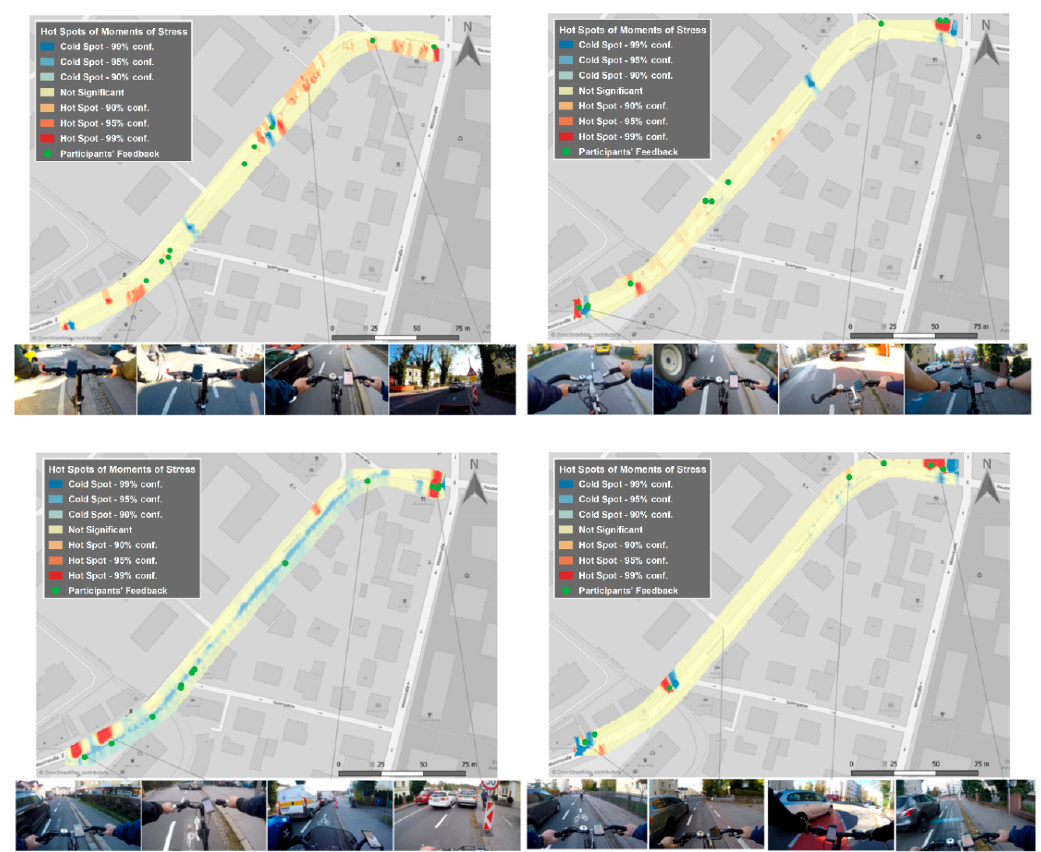
Figure 5. Hot spots (stress clusters) and cold spots (areas of relaxation) in the Urban Bicycle Network.